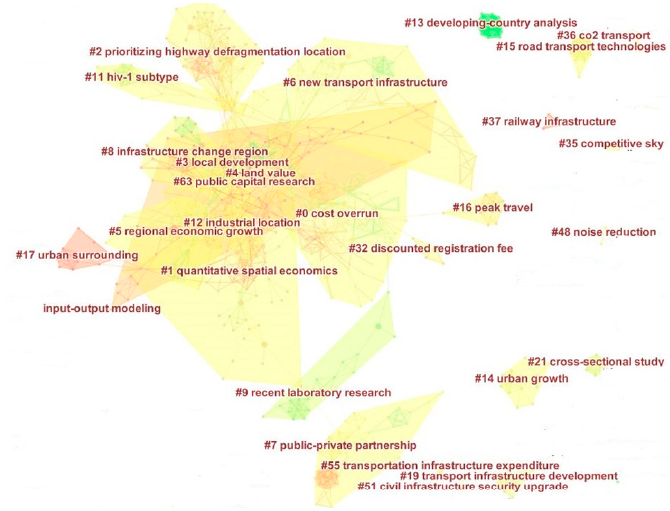
Figure 10. A landscape view of the co-citation network.